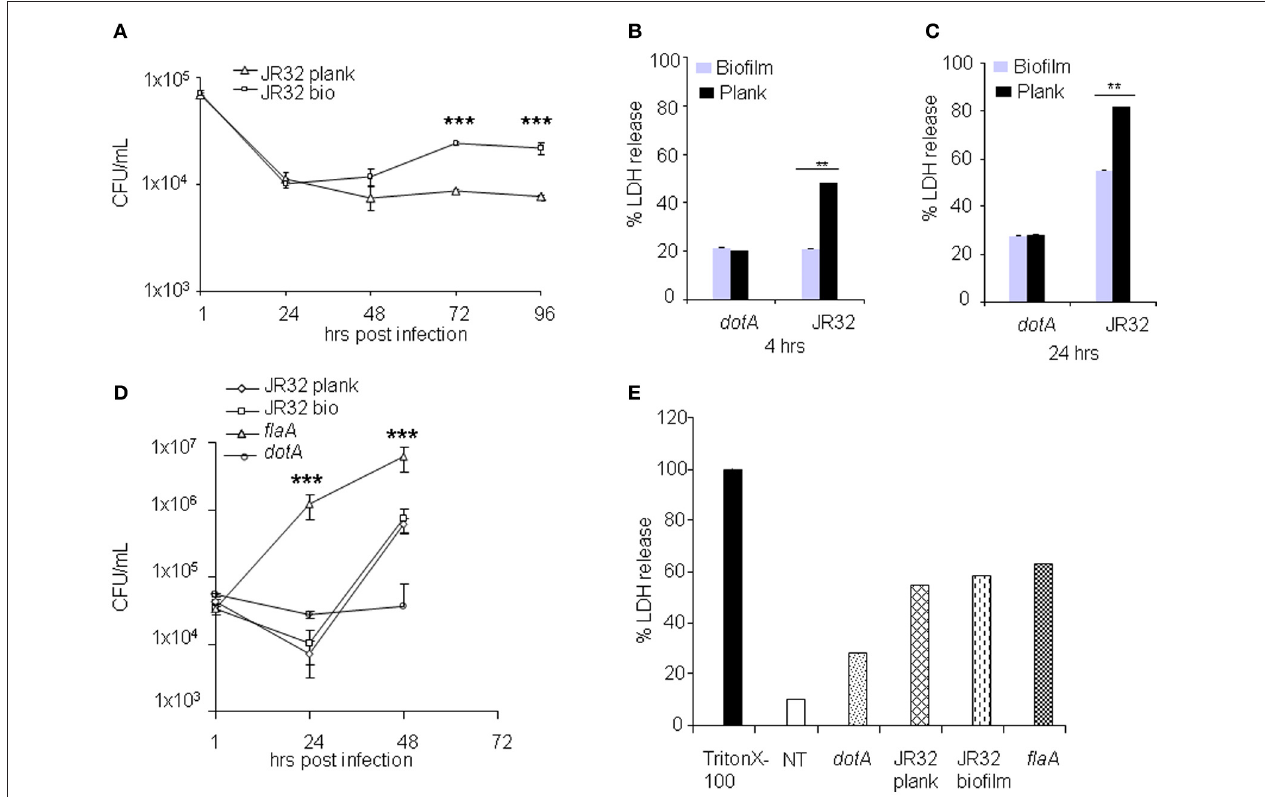
FIGURE 2 | Biofilm-derived L. pneumophila replicatessignificantlymore andinduceslessmurinemacrophagesdeaththantheplanktonicbacteria. (A) BMDMswereinfectedwithplanktonicorbiofilm-derived L.pneumophila at an MOIof 0.5.CFUswerescoredat 1,24,48,72,and 96h.Dataare